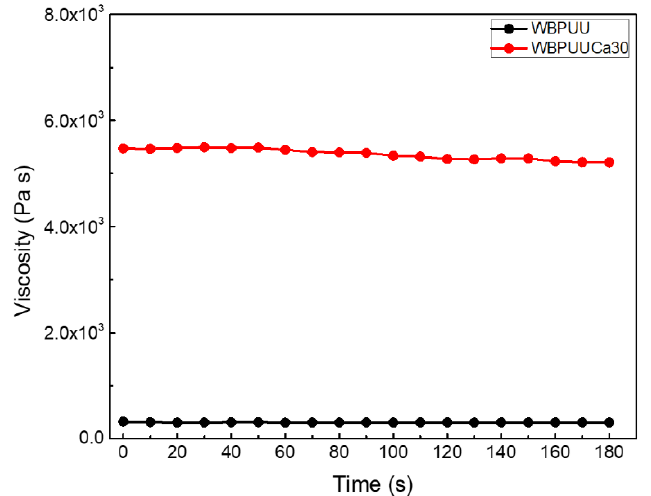
Figure 3. Viscosity as a function of time at a shear rate of 1 s − 1 (T = 22.5 °C) for WBPUU before and after the immersion in CaCl 2.